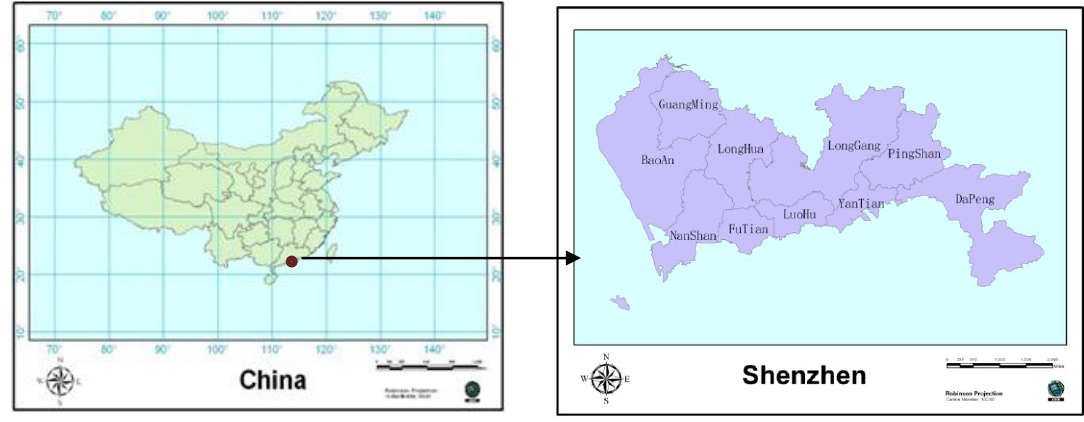
Figure 1. The location of Shenzhen City in China; the names of districts in Shenzhen